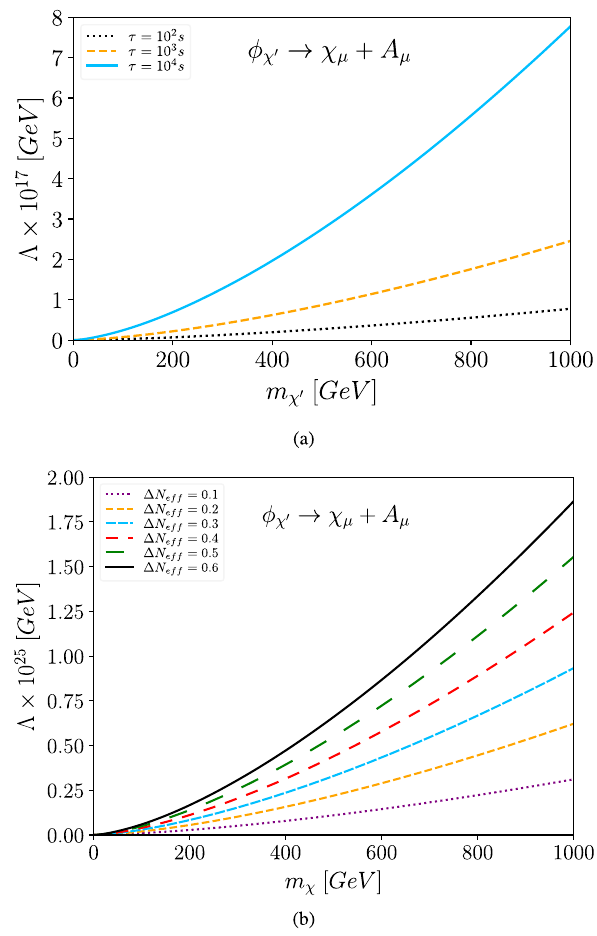
Fig. 6 Plotof (cid:2) asafunctionofthe χ and χ (cid:4) massesforthecasewhere χ (cid:4) has spin-0 and χ is a spin-1 particle. a (cid:2) × m χ (cid:4) curves built from Eq. (27), using τ = 10 2 , 10 3 and10 4 s. b (cid:2) × m χ curves constructed from Eqs. (16) and (27). We consider the cases where (cid:9) N ef f = 0.1–0.6, with f = 0 . 01 and m χ (cid:4) / m χ = 10